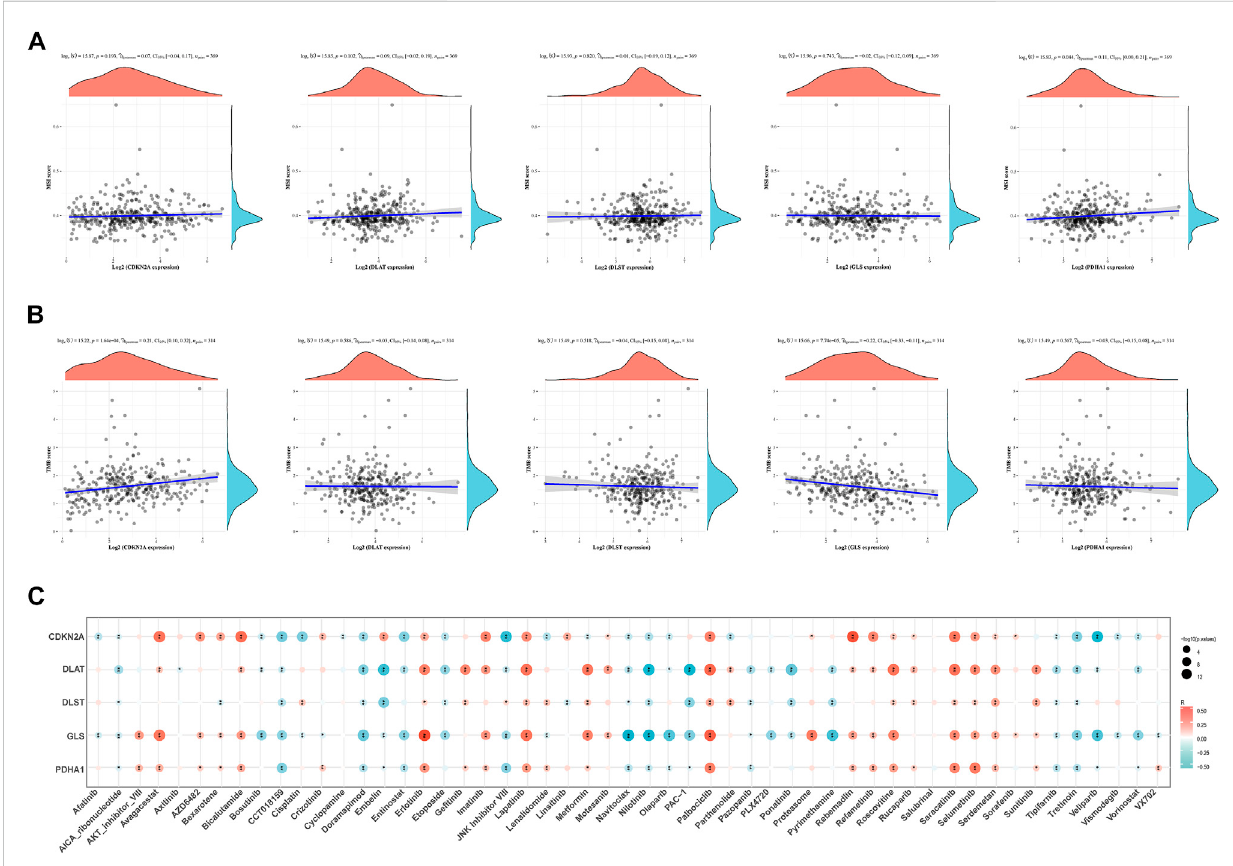
FIGURE 11 TMB,MSIanddrugsensitivity. (A) CorrelationbetweentheexpressionofprognosticCRGsandMSIinHCC. (B) CorrelationbetweenprognosticCRGs and TMB in HCC. (C) Correlation between prognostic CRGs and antitumor drugs in HCC. TMB, tumor mutational burden; MSI, microsatellite